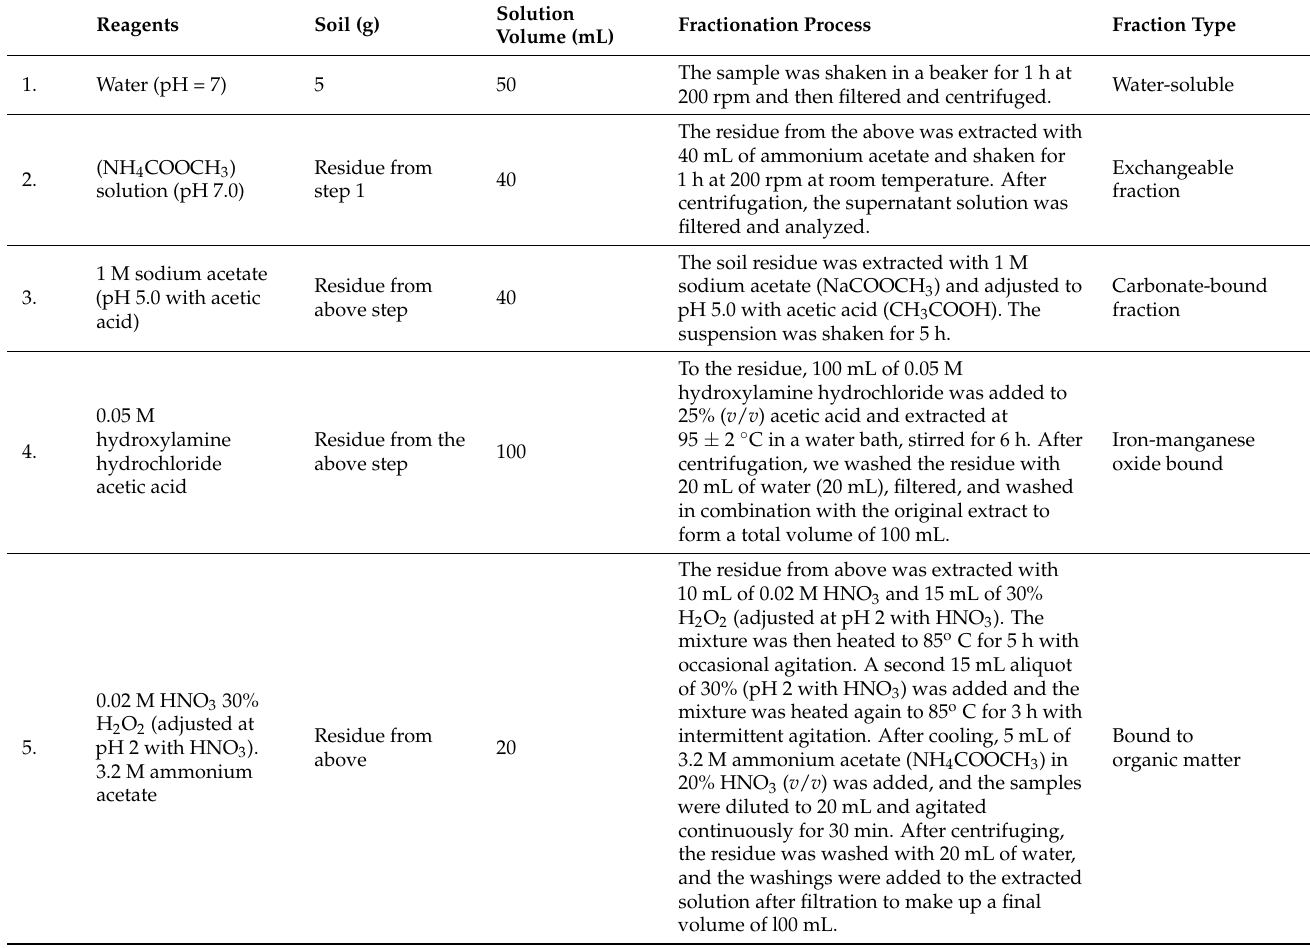
Table 1. Tessier et al. [22] extraction